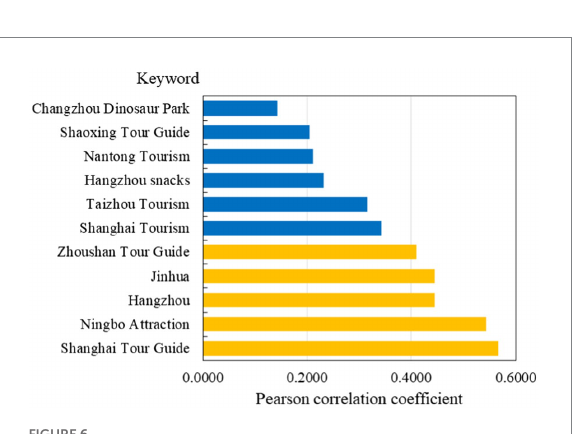
FIGURE 6 The Pearson correlation coefficients between partial SEDs and the predicted